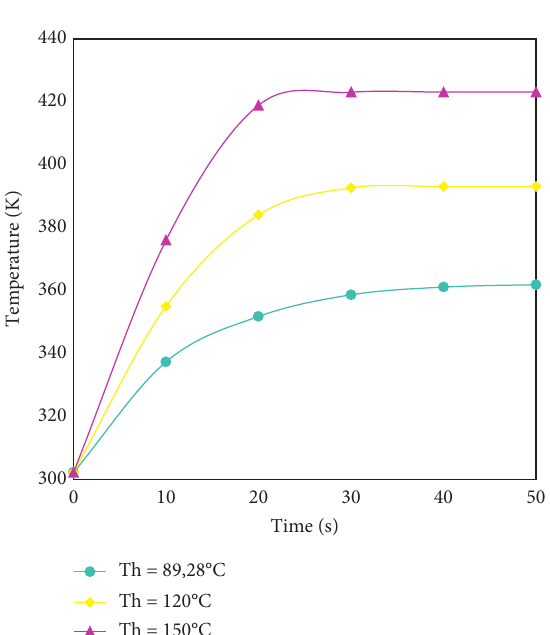
Figure 4: Variation of average bed temperature with time for different T